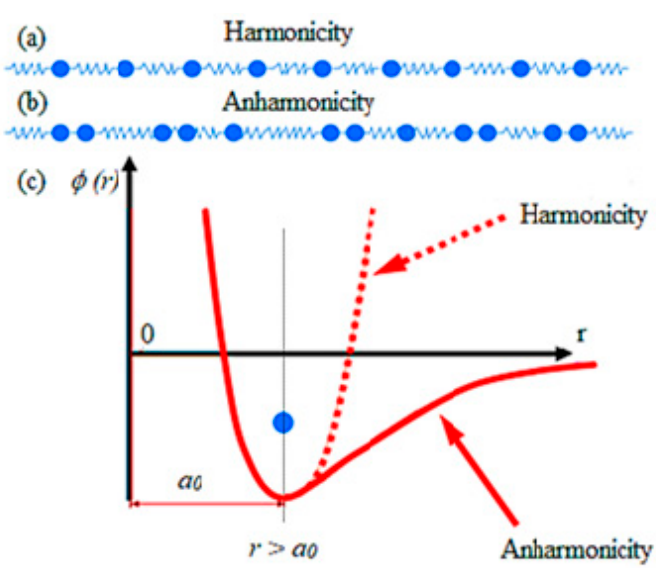
Figure 2. The schematic representations of ( a ) harmonicity and ( b ) anharmonicity. Meanwhile, ( c ) the harmonicity represents a balanced phonon transport, whereas the anharmonicity represents an imbalanced phonon transport. Reprinted with permission from [92].